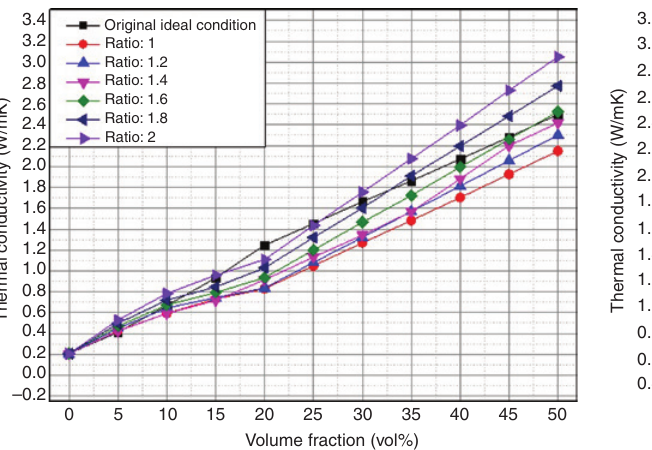
Figure 5: Comparison of the different length-width ratios of rectan- gular particles.